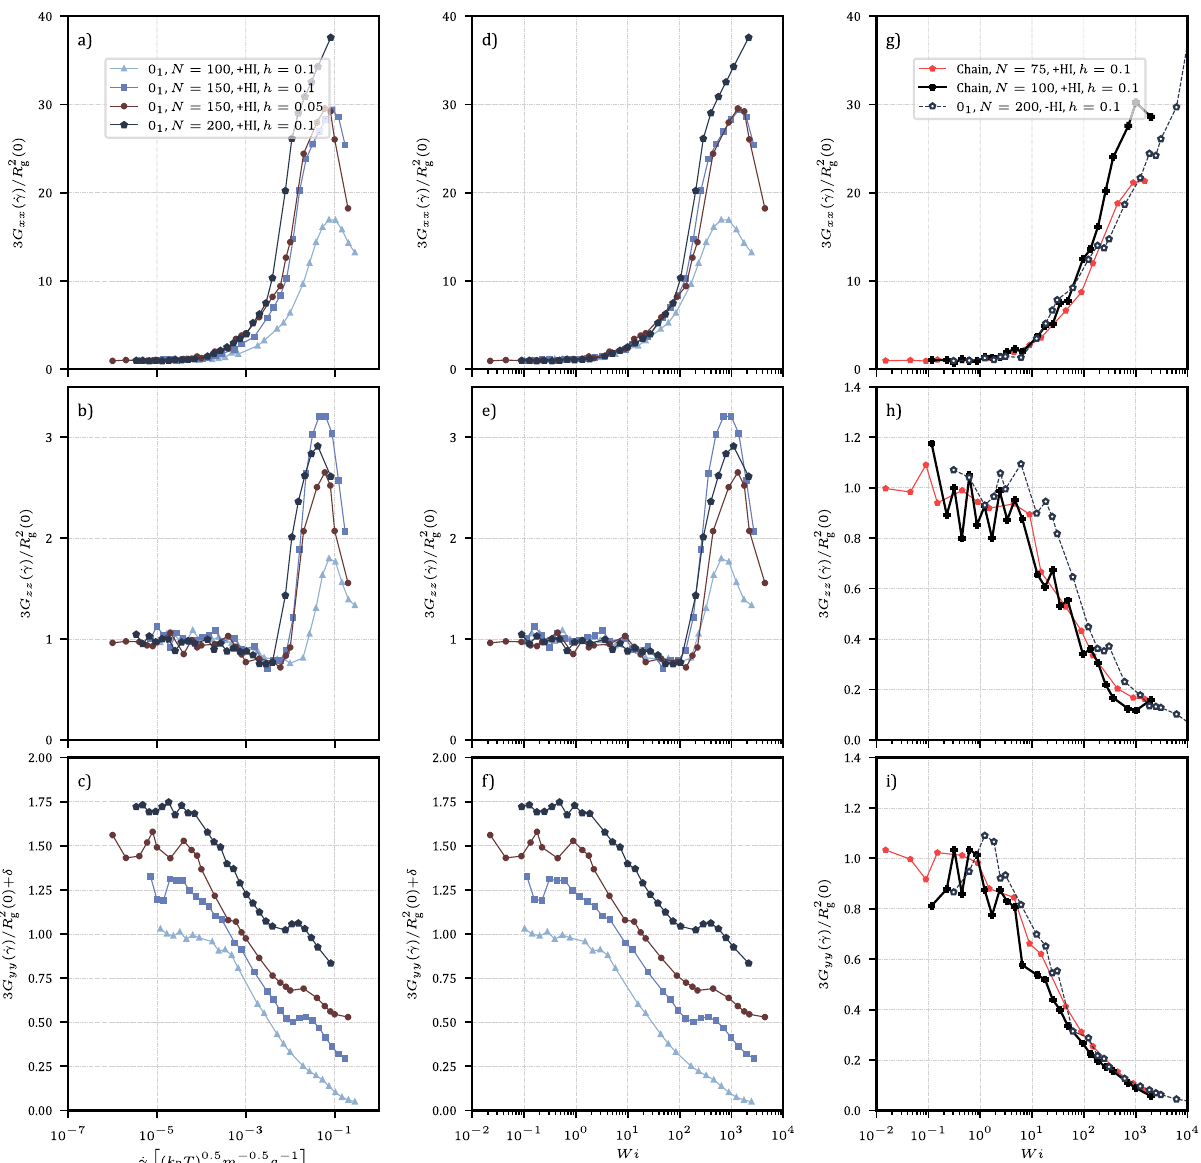
Fig. 1 Diagonal components of the gyration tensor. a – f Diagonal gyration tensor elements G αα ð _ γ Þ for a set of rings, normalised over their equilibrium value _ γ in panels a – c and against Weissenberg number Wi in panels d – f . A more complete R 2 ð 0 Þ = 3 where R g is the radius of gyration, against the shear rate g discussion of gyration tensor G and the values obtained from it can be found in the Supplementary Methods. g – i Diagonal gyration tensor elements G αα ð _ γ Þ ð 0 Þ = 3 where R for a set of chains including HI and the N = 200-ring without HI for reference, normalised over their equilibrium value R 2 g is the radius of g gyration, against Weissenberg number Wi . a G xx ( fl ow direction) increases with shear rate to some maximum and then drops as rings align into the _ γ that anticipate the fl ow – vorticity plane and experience less strain. b G zz (vorticity direction) decreases to a minimum and then shoots up at values of in fl ation anomaly observed in panel c for the gradient direction. c G yy (gradient direction) initially decreases with shear rate. For N = 150 and N = 200, an in fl ation anomaly is observed, which is hardly visible for N = 100. The same anomaly is reproduced for MPCD collision time step h = 0.05 for the N = 150- ring. To highlight this behaviour, shifts δ have been applied along the vertical axis, where δ N = 100 = 0.0, δ N = 150 = 0.25 ( h = 0.1), δ N = 150 = 0.5 ( h = 0.05) and δ N = 200 = 0.75. g G xx ( fl ow direction) increases with shear rate and eventually saturates for chains. Saturation was not yet reached for the N = 200-ring without HI. h G zz (vorticity direction) decreases continuously. The anomaly of rings with HI presented in panels b and e is absent here. i G yy (gradient direction) decreases with shear rate. As the anomaly in panels c and f is not shown by chains nor rings without HI, no shift was applied to these